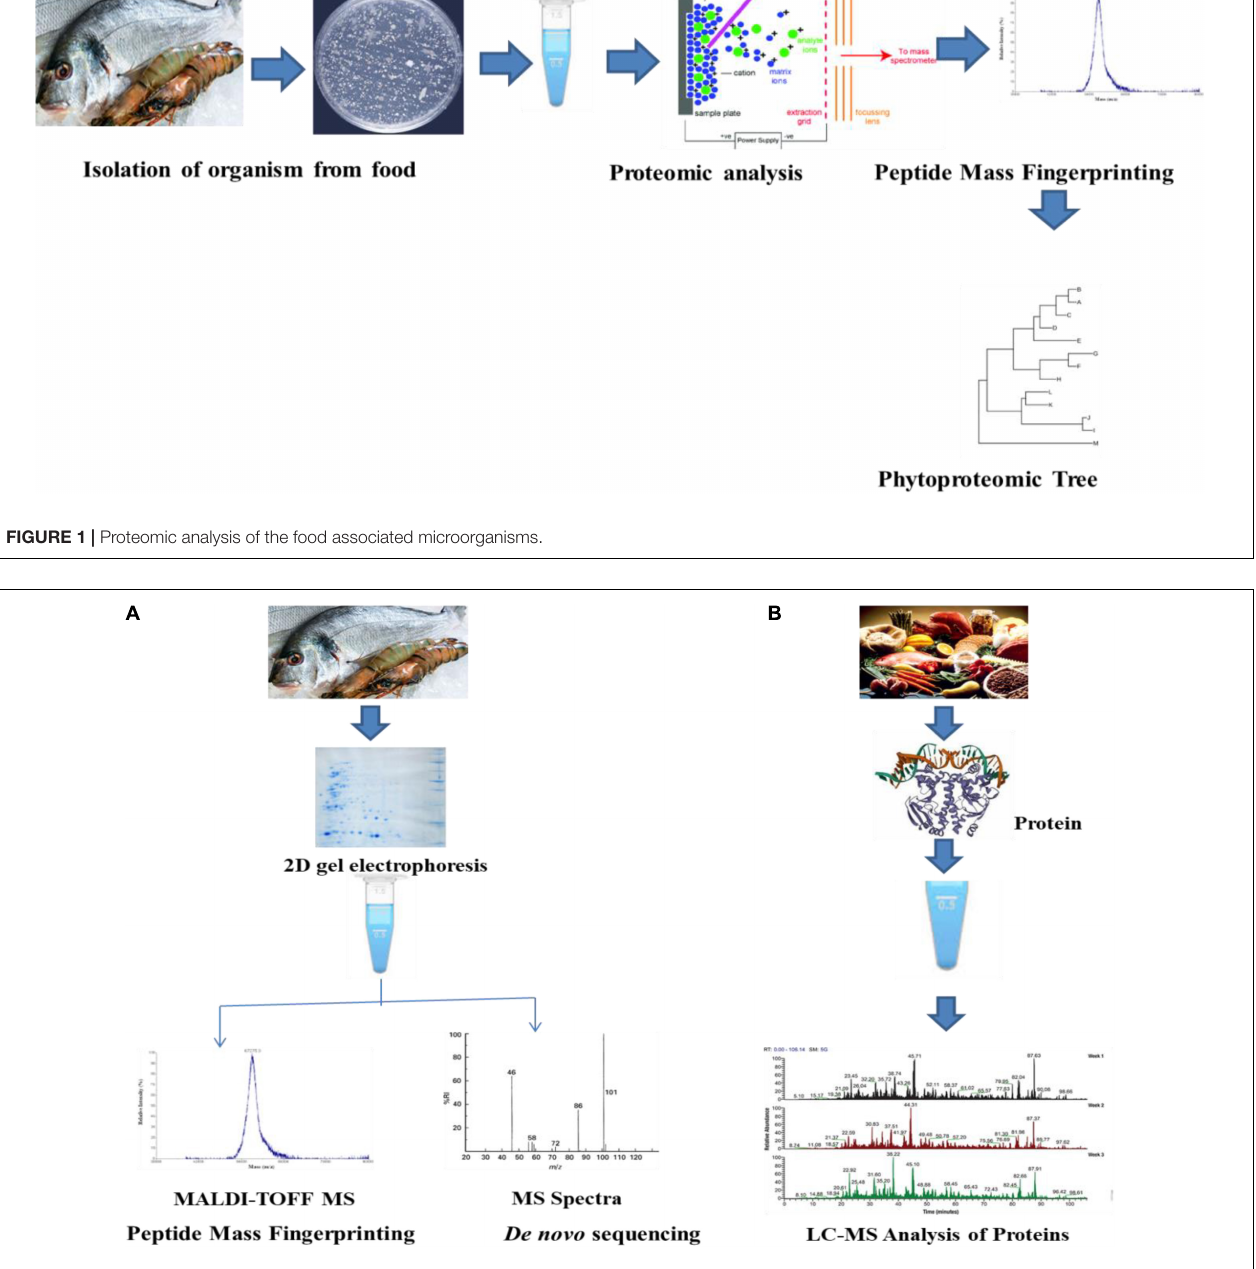
FIGURE 2 | Discovery phase (A) and target phase (B) analysis of proteomics in